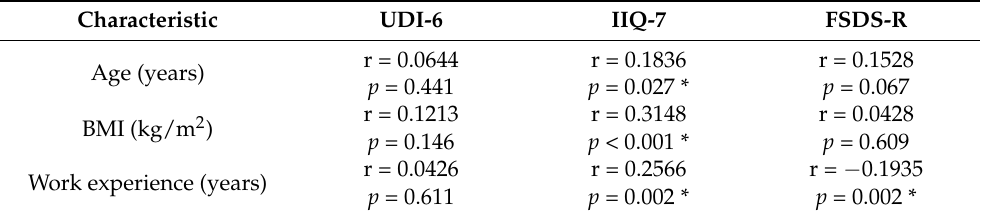
Table 4. Correlations between the results obtained from the questionnaires and the data characterizing the studied group (N = 145).